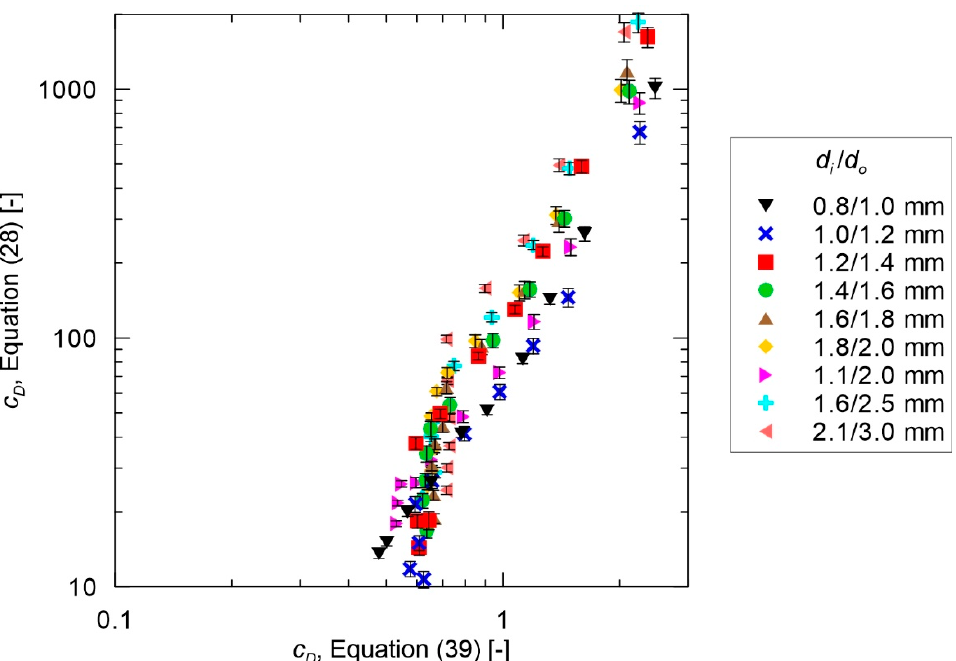
Figure 6. Comparison of drag coe ffi cient, c D , calculated using Equation (28) versus drag coe ffi cient calculated using Equation (39).